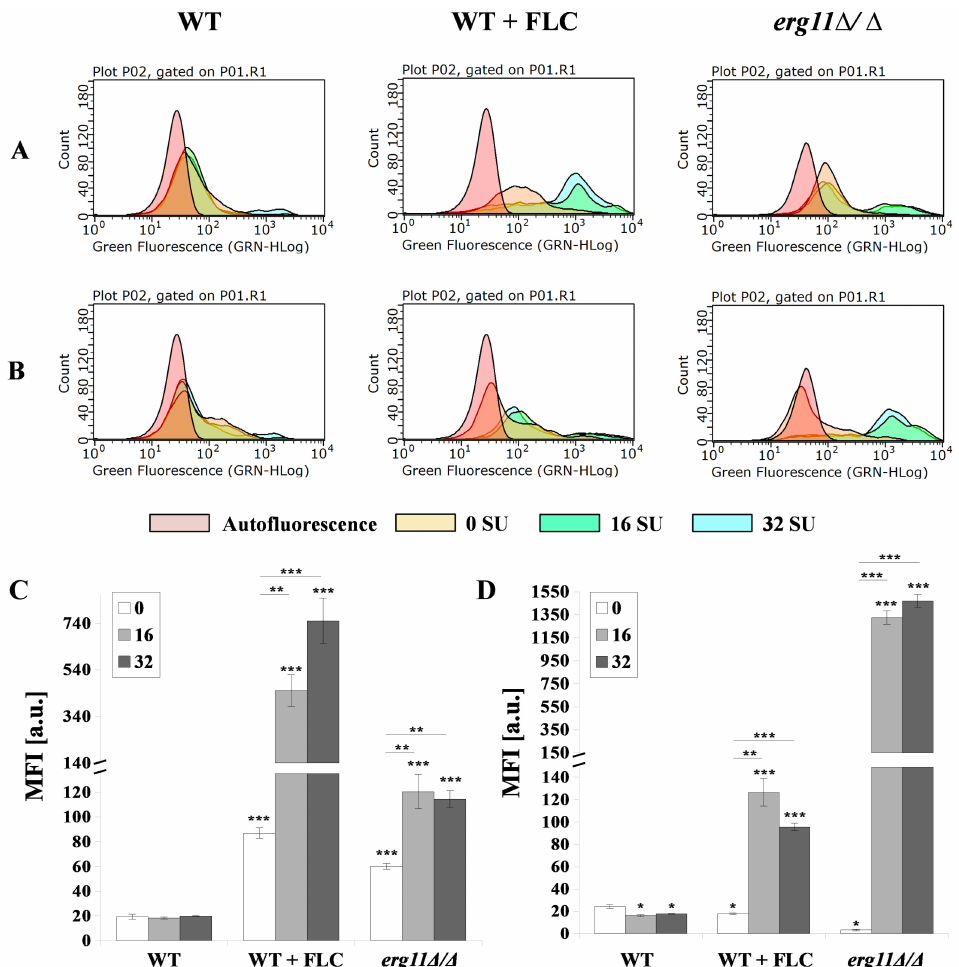
Figure 5. Exposure of ( A , C ) chitin and ( B , D ) β -glucan in C. albicans CAF2-1 (WT) or KS028 ( erg11 ∆ / ∆ ) strains grown for 24h in YPD without and the addition of 16 or 32 µ g / mL surfactin (0 SU, yellow; 16 SU, green and 32 SU, blue). The CAF2-1 strain was simultaneously treated with 1 µ g / mL fluconazole (FLC) and SU. In each case, cells were fixed and stained with Fc-hDectin-1 and Alexa Fluor 448-conjugated anti-human IgG Fc antibodies or wheat germ agglutinin conjugated with FITC (WGA-FITC) and quantified by FACS ( A , B ). All results were compared to unstained CAF2-1 or KS028 cells (autofluorescence, red). Presented data are representative of three independent experiments. Medianfluorescenceintensities(MFIs)( C , D )werequantifiedforallthreeexperiments. Autofluorescence of either CAF2-1 or KS028 unstained cells was subtracted. Statistical analyses were performed relative to control experiments using CAF2-1 untreated with SU (above bars) or in the case of WT + FLC and erg11 ∆ / ∆ additionally between SU-treated cells (16SU or 32SU) or SU-nontreated (0SU) (above lines) (*, P < 0.05; **, P < 0.01; ***, P <